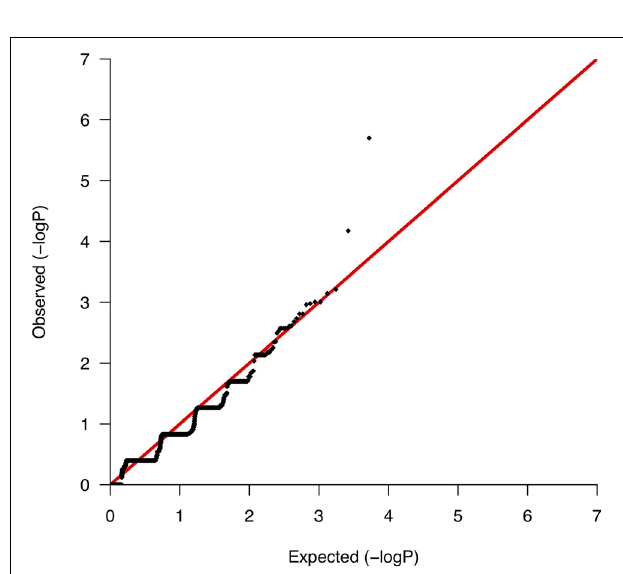
FIGURE 2 | Quantile-quantile plot of the mutation burden test results from the association with mortality.